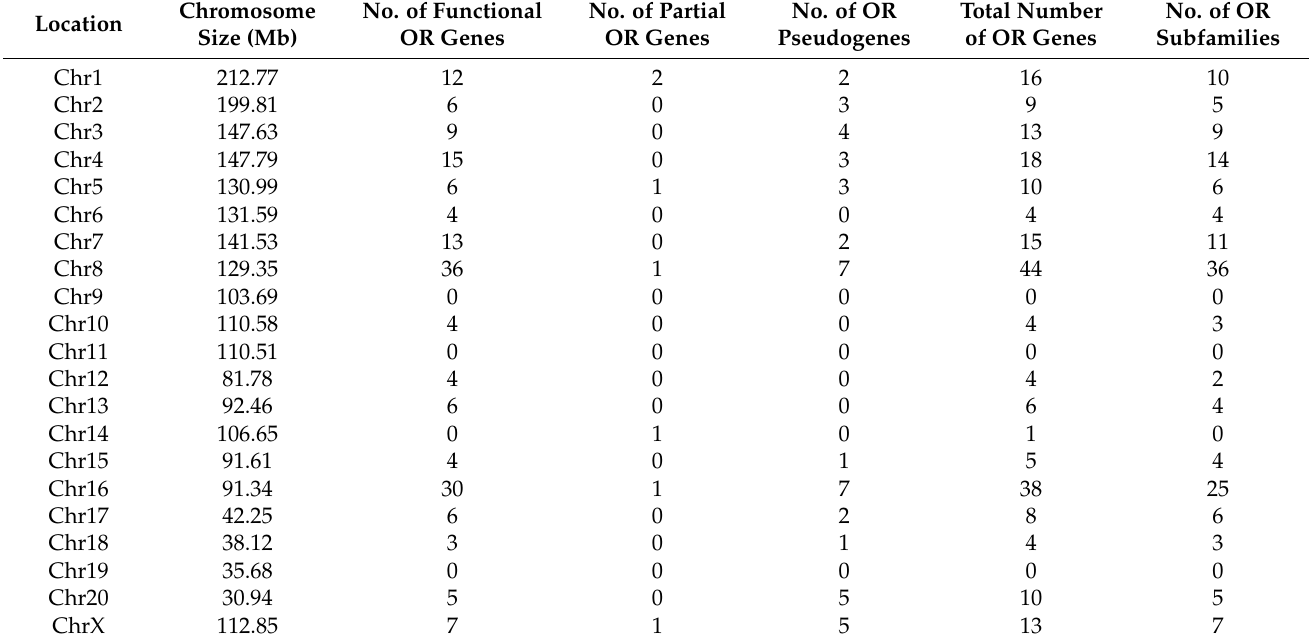
Table 2. Composition of OR genes for each chromosome of the giant panda.